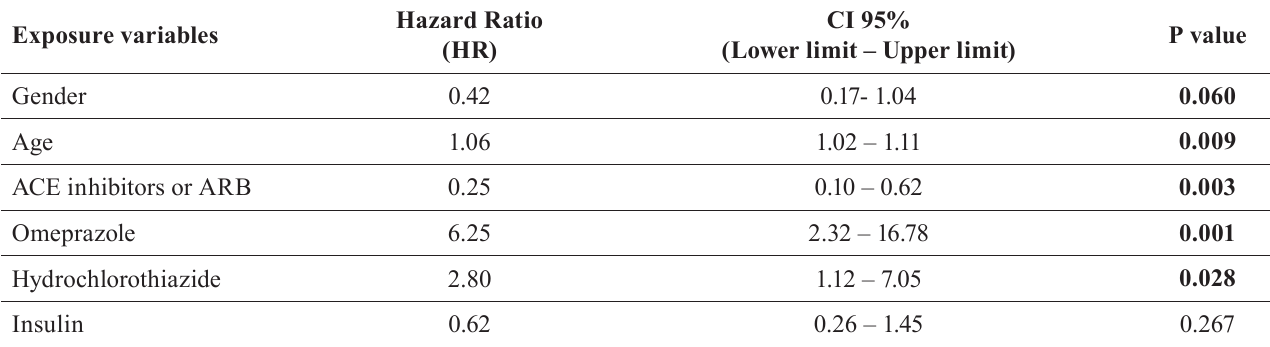
TABLE III - Multivariate Cox Regression Analysis, with the outcome variable being the need for RRT, or death.